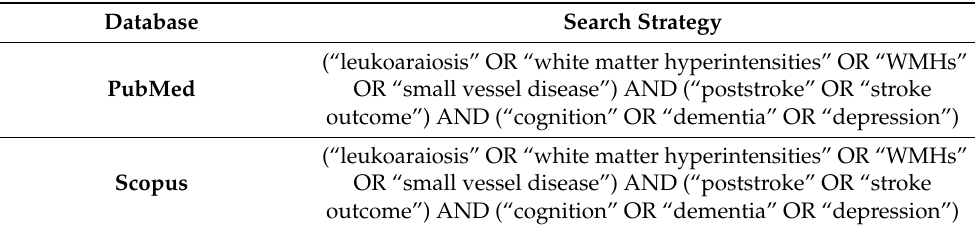
Table 1. Employed databases and search strategies.